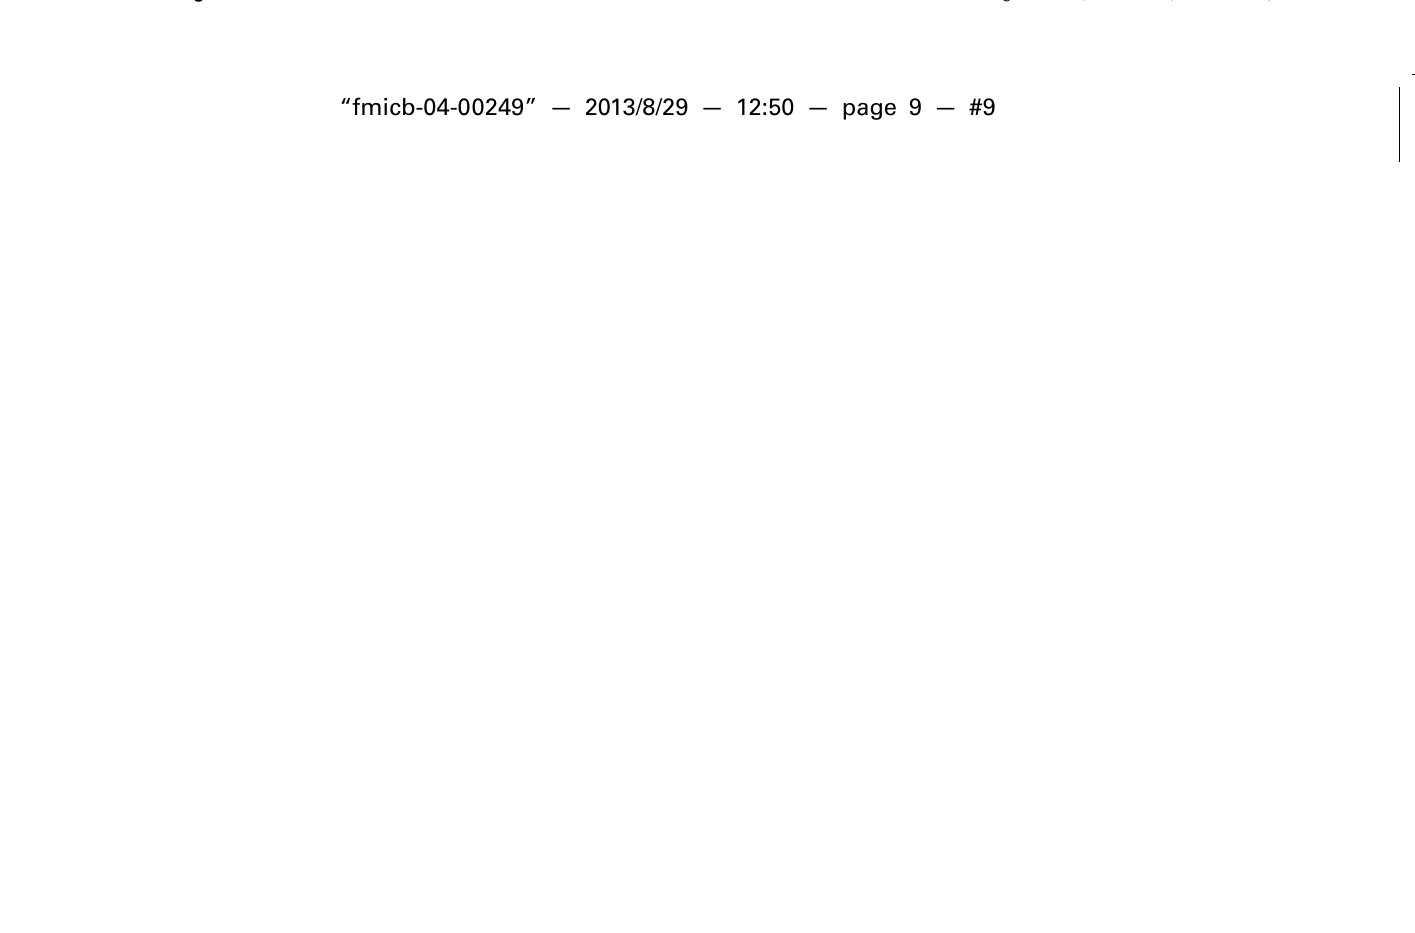
Expression data for genes encoding predicted proteins with the CXXCH motif (including c -type cytochromes) are presented in Figure 2 . The log 2 intensity data plotted in Figure 2 were nor- malized as described in Section “Materials and Methods” and represent, with one exception, the average of three biological replicates, each of which had three technical on-chip replicates. The exception is the “UO 2 (synth.)” column, which represents only one biological replicate. The exposure conditions for the arrays (displayed directly above the heat map) listed from left to right are the same as the conditions listed in Table 1 from top to